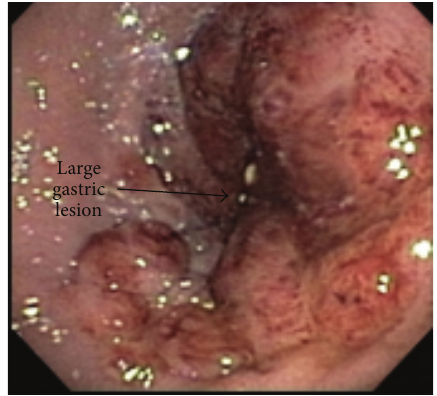
Figure 1: Large gastric lesion.